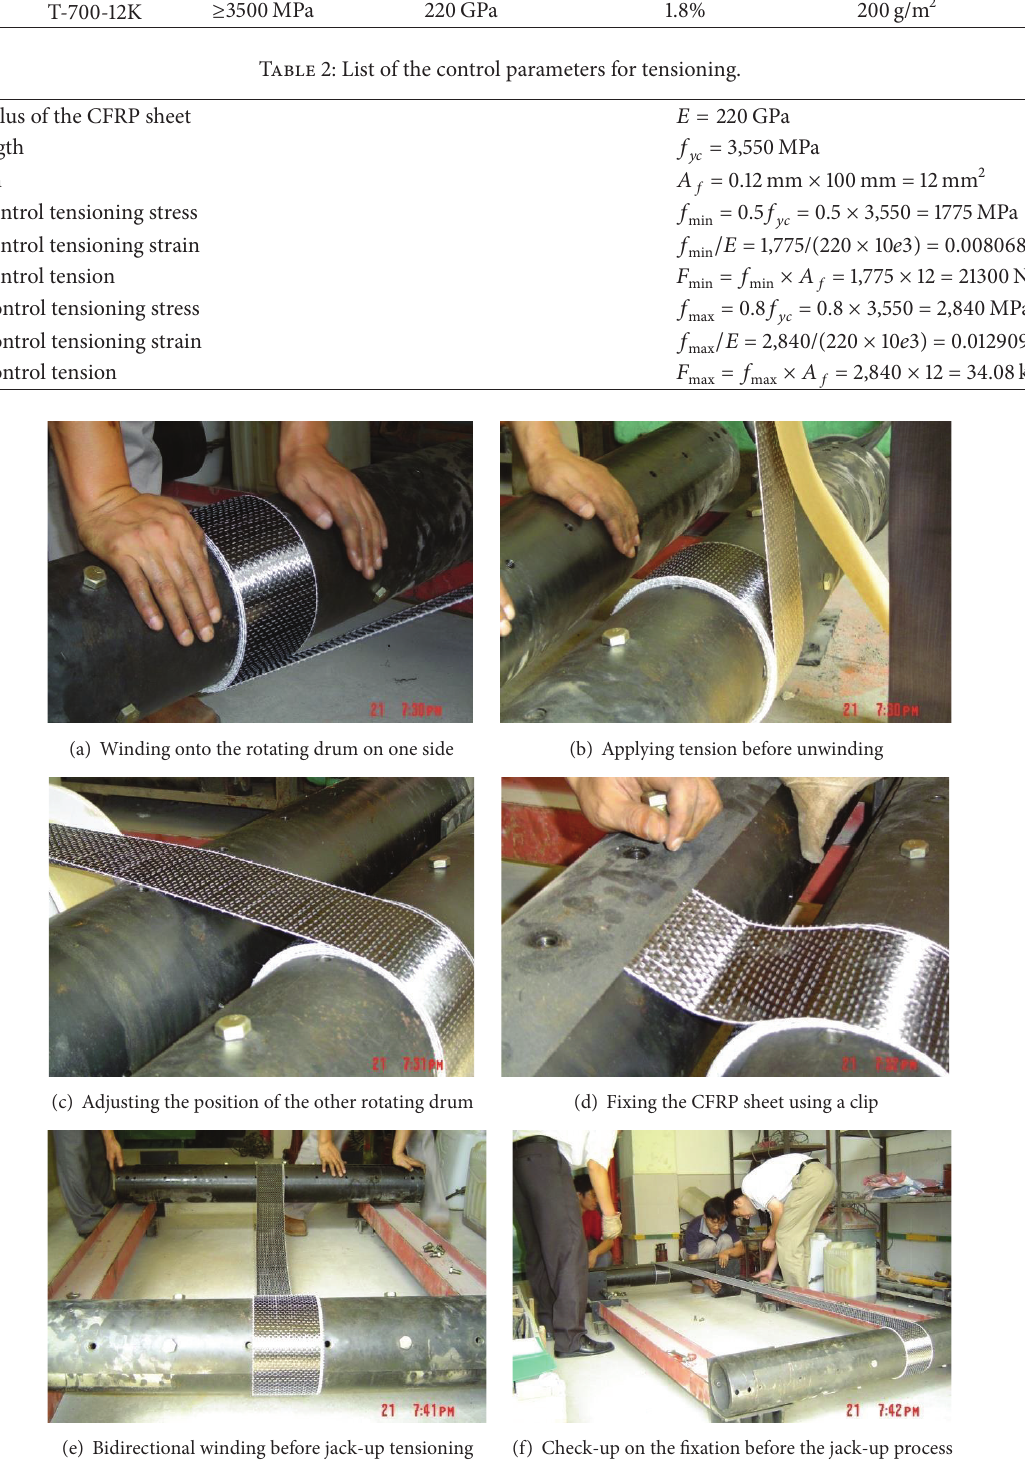
Figure 2: Jack-up tensioning